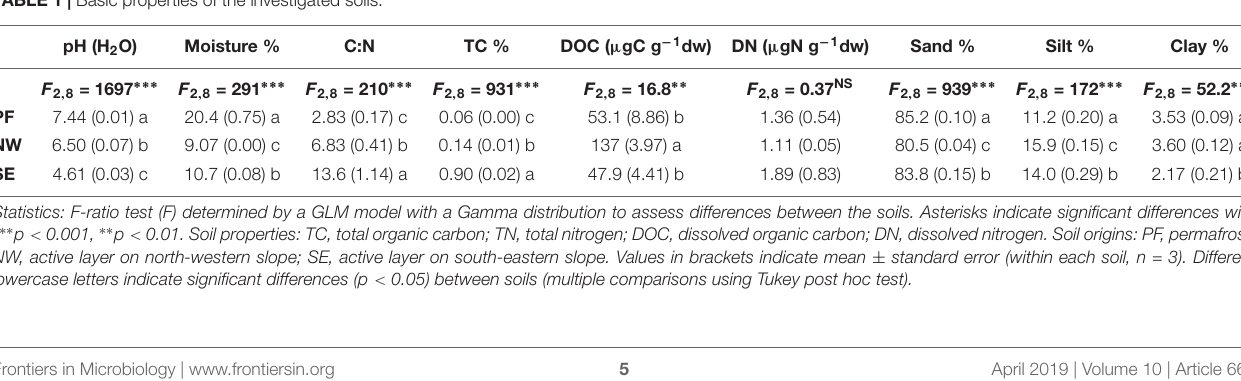
TABLE 1 | Basic properties of the investigated soils.